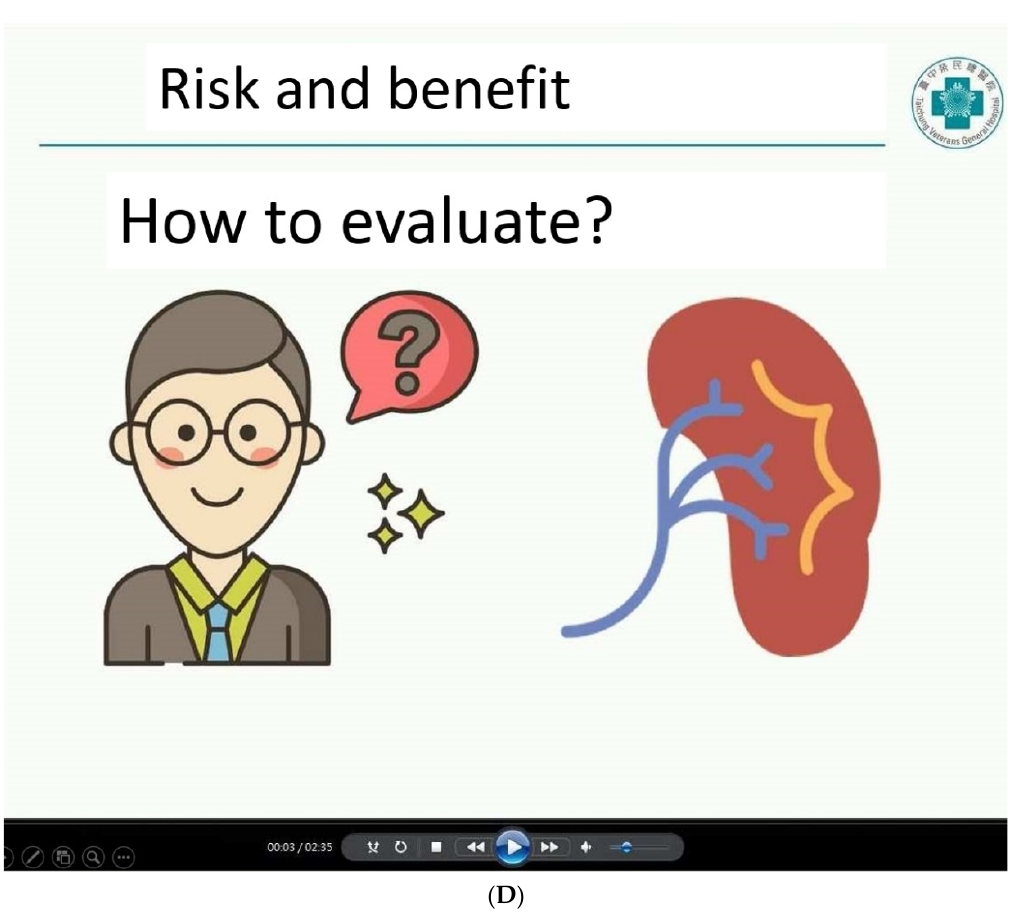
Figure 5. Patient decision aid (video). Duration of video: 3 min and 18 s. ( A ) The introduction of renal biopsy. Duration of video: 3 min and 10 s. ( B ) Live video for renal biopsy. Duration of video: 2 min and 35 s. ( C ) Benefit and risk of renal biopsy. Duration of video: 3 min and 18 s. ( D ) Other alternative choices. Duration of video: 2 min and 36 s.